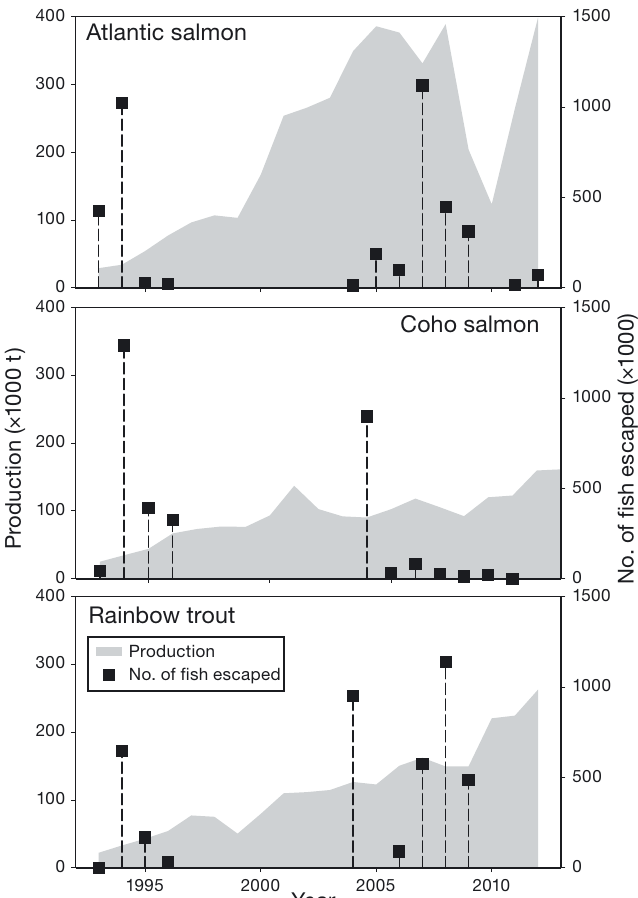
Fig. 4. Total salmonid production and reported escapes. Es- cape data for 1993 to 1996 from Soto et al. (1997) and for 2004 to 2012 from the National Fisheries Service (unpubl. in- formation). Production data for 1993 to 2012 from FAO aqua- culture statistics